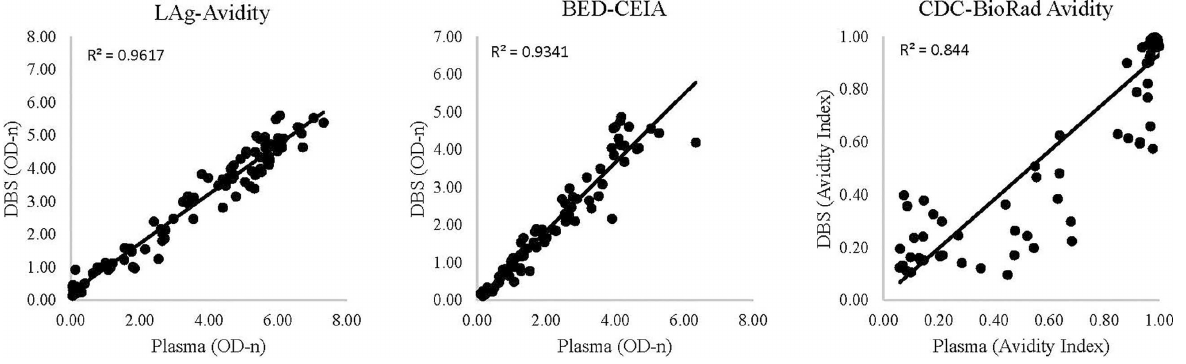
Fig 1. Correlation of results from matched plasma and DBS samples tested with LAg-Avidity, BED-CEIA, and CDC-BioRad Avidity.